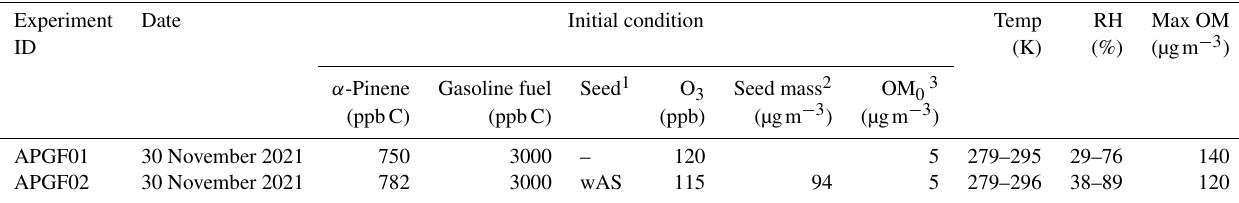
Table 2. Experimental conditions for the oxidation of α -pinene with gasoline fuel in the UF-APHOR chamber. Experiment